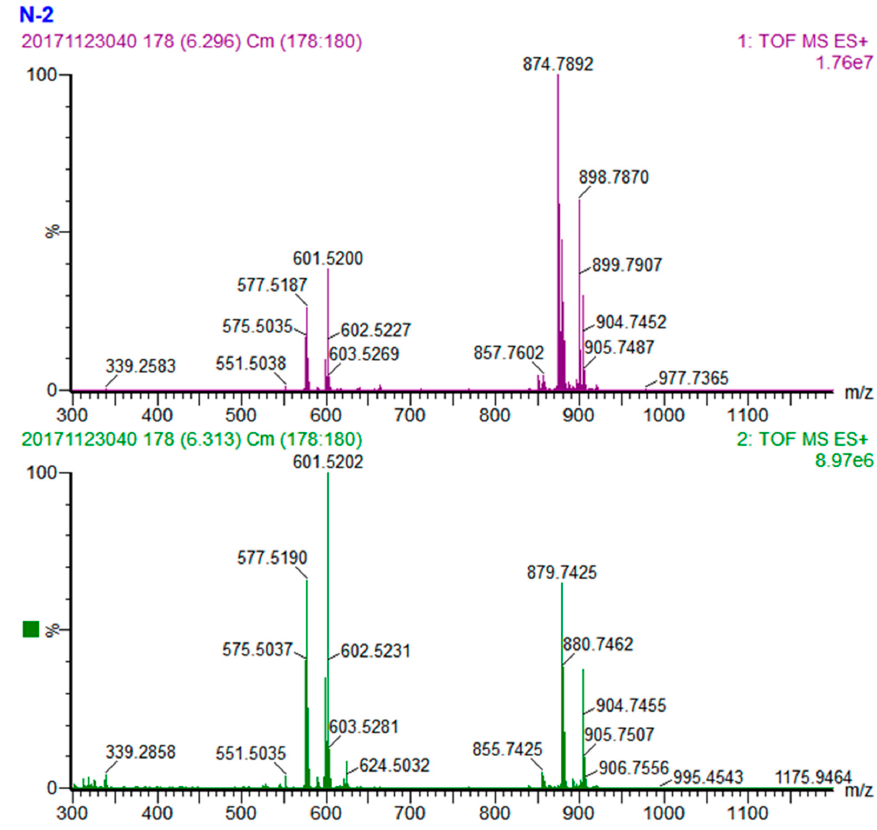
Figure 4. MS spectra of POL. ( Upper ) MS1 spectrum and ( lower ) MS2 spectrum.